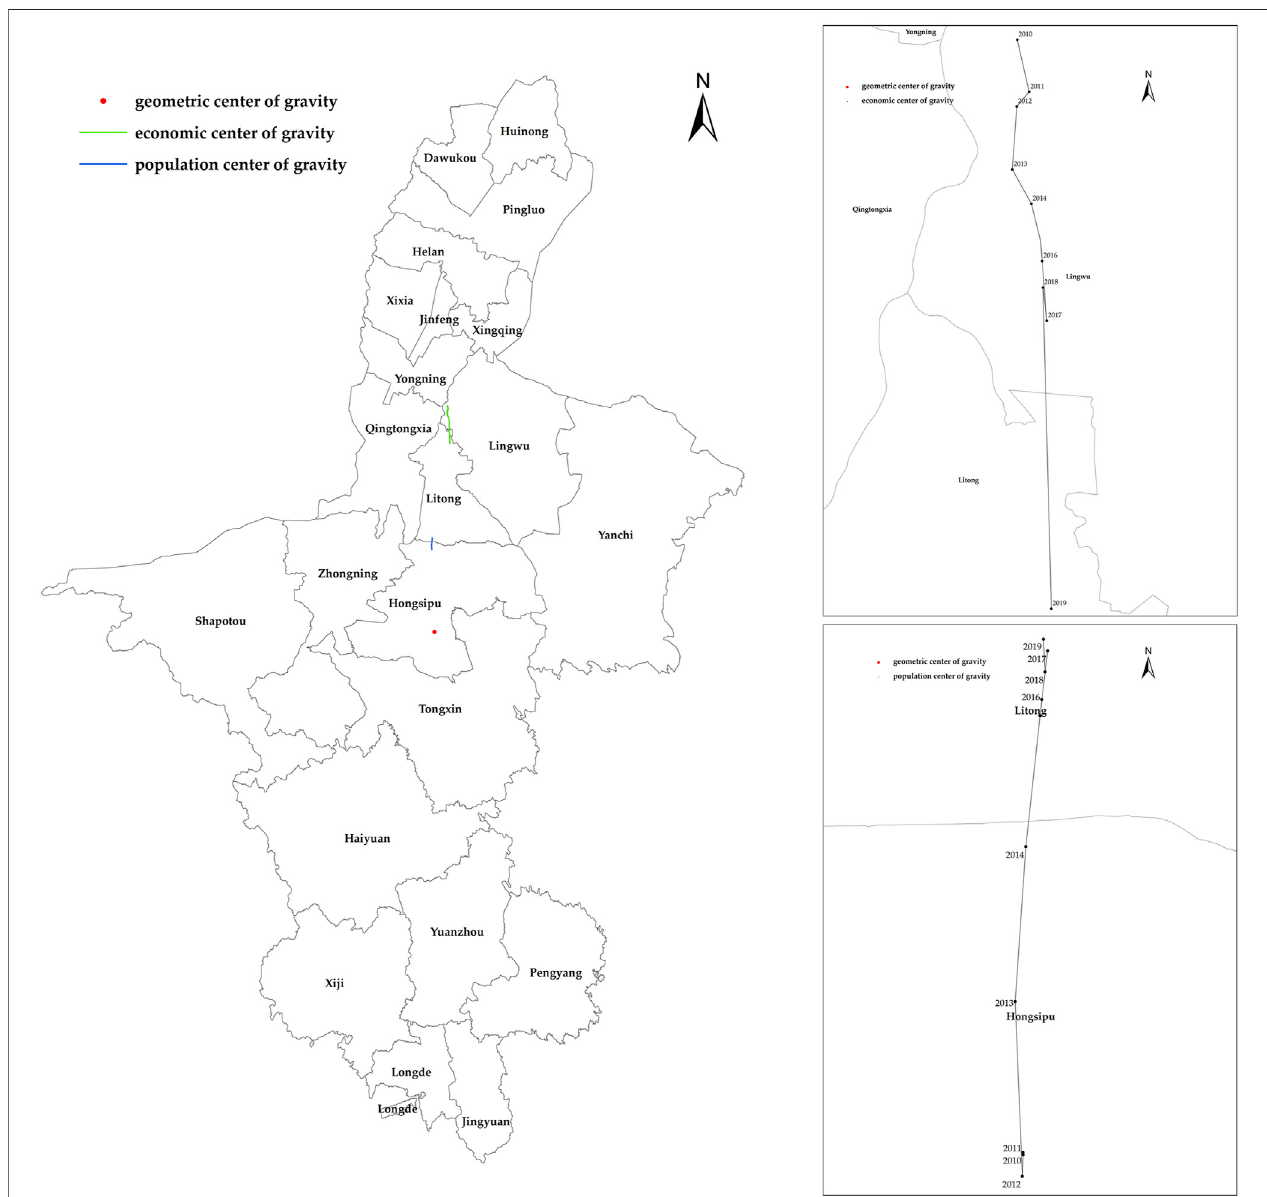
FIGURE 4 | The gravity center evolution of Ningxia ’ s population and economy from 2010 to